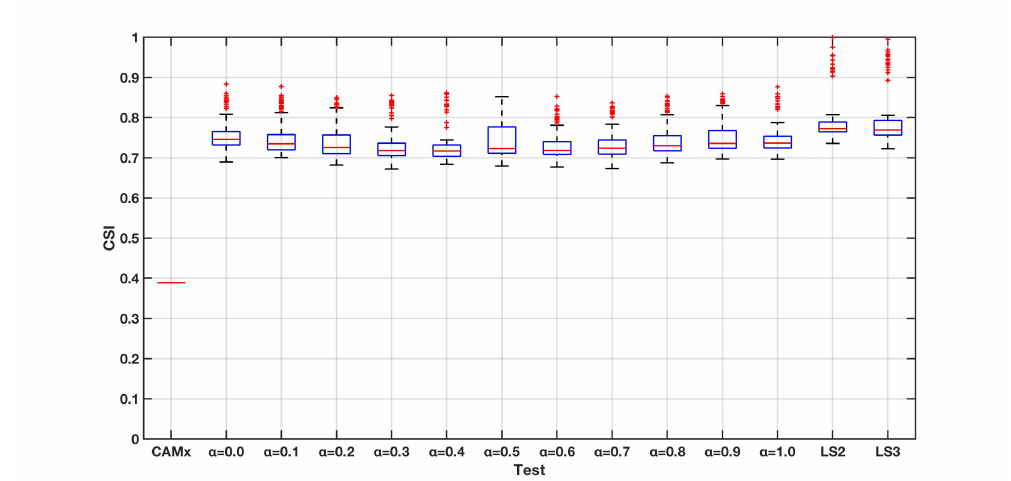
Figure 10. SI for the one-step-forward forecast.